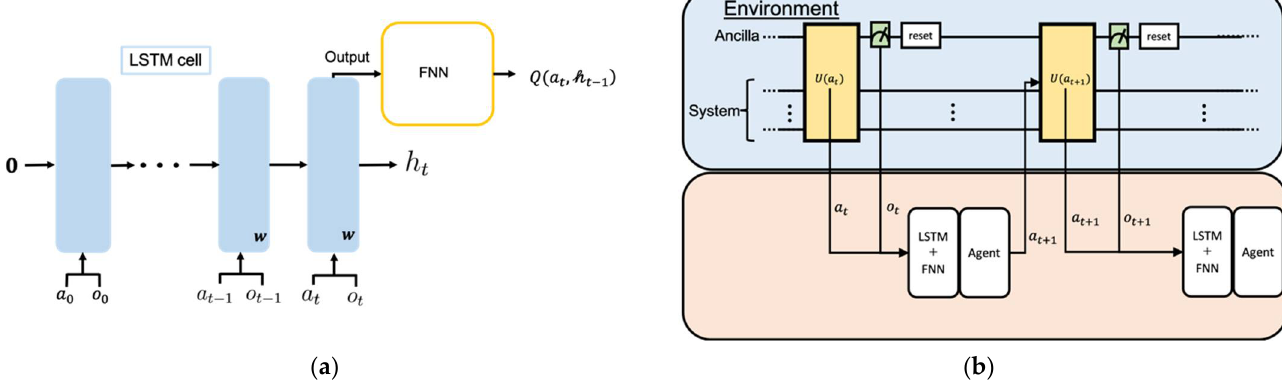
Figure 1. The setting of the proposed learning algorithm. ( a ) A LSTM cell and a feed-forward neural network (FNN) are used for history Q-function approximation. ( b ) The RL environment–agent diagram. Table 1. List of